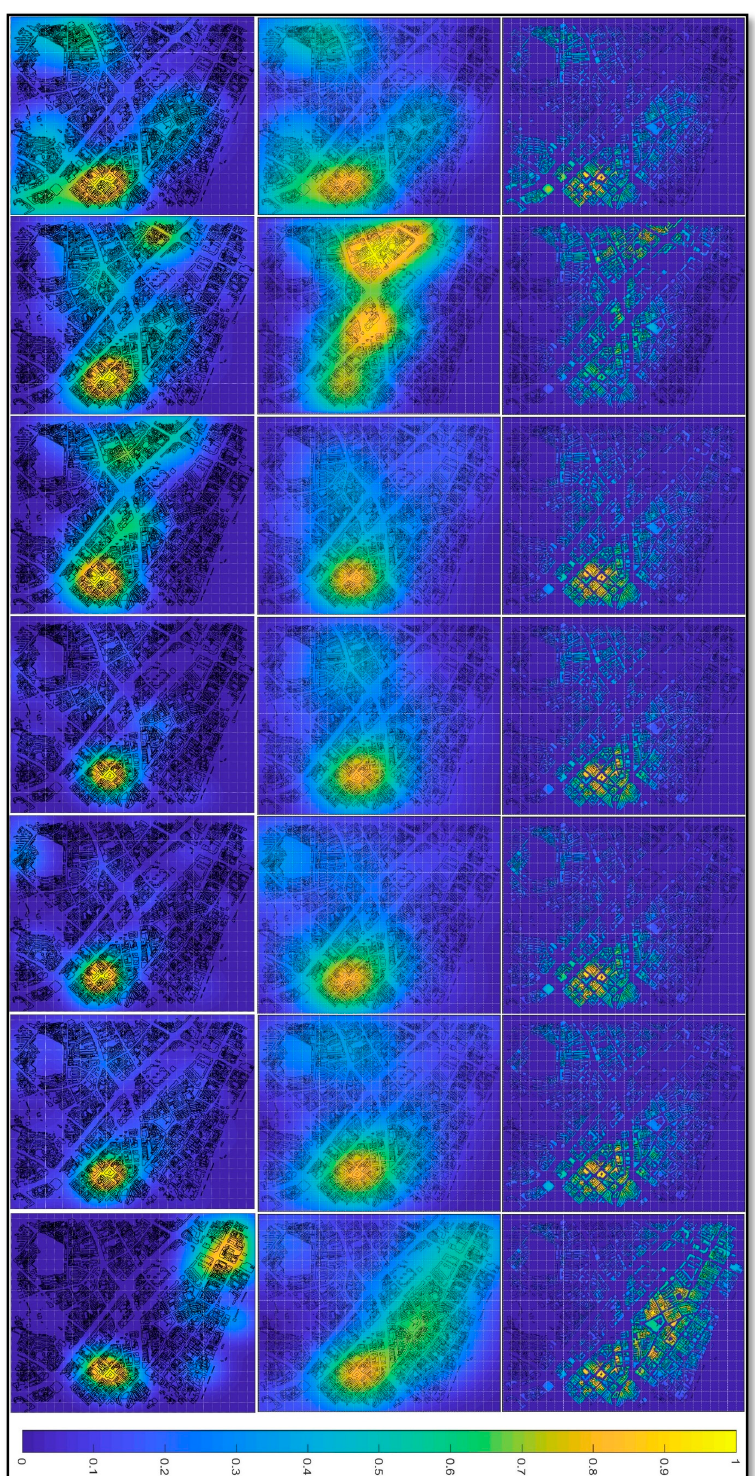
Figure 9. Spatial KDE (first column), IsotDM (second column) and AnisDM (third column).